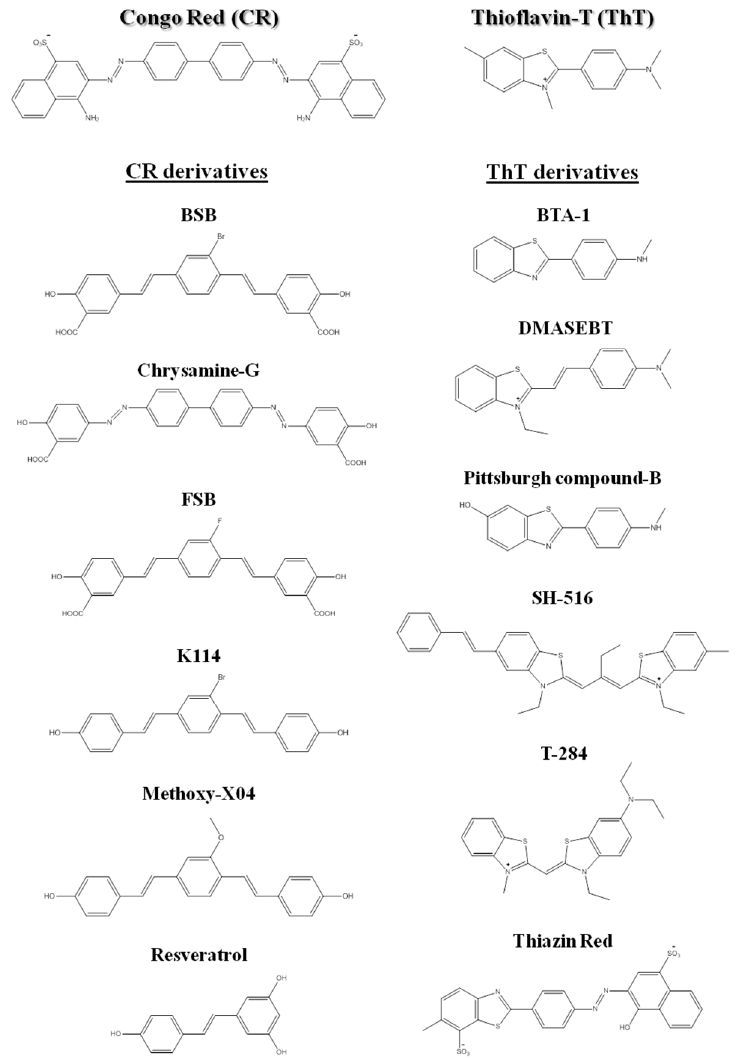
Figure 2. Chemical structures of Congo red, thioflavin-T, and some of their derivatives used in amyloid fibril detection.